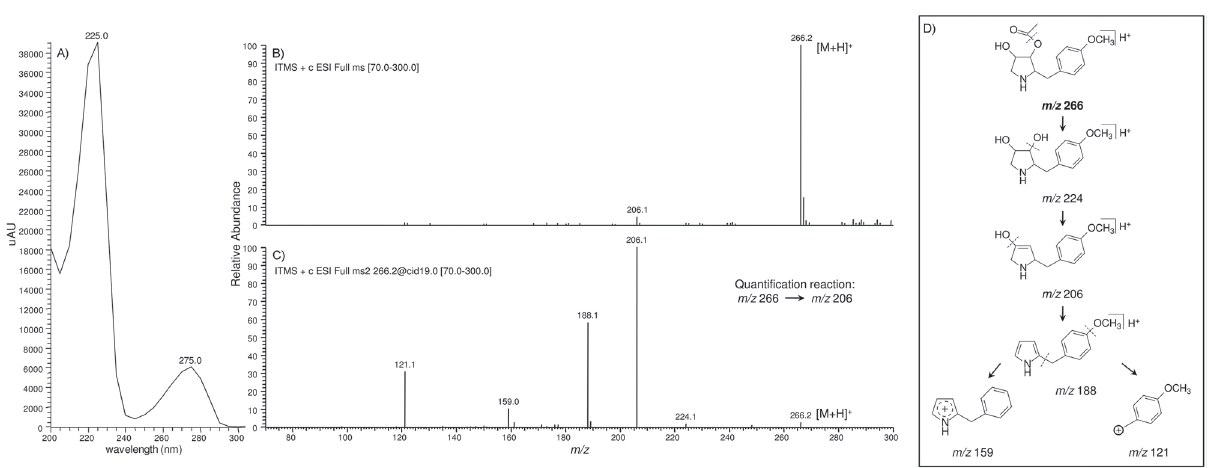
FIGURE 1 - Anisomycin spectra: A) UV spectrum, B) mass spectrum, C) MS/MS spectrum of the protonated molecule, and D) proposed fragmentation pathway of